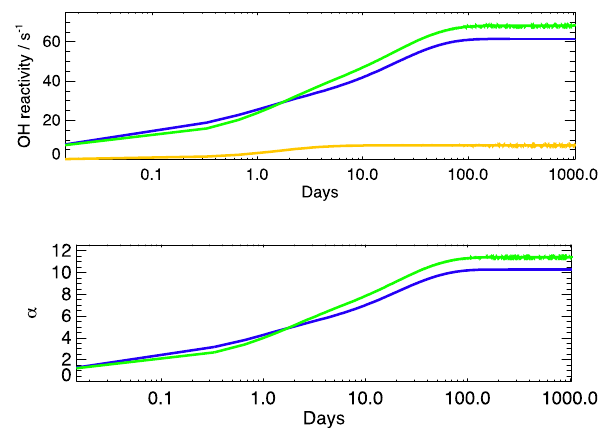
Figure 6: Time evolution of simulated OH reactivity (upper plot) and α (OH reactivity divided by the reactivity due to the primary VOC alone) (lower plot) in a model simulation with fixed Fig. 6. Time evolution of simulated OH reactivity (upper plot) and mixing ratios / concentrations of 2.5 ppbv of ethene (green), ethane (yellow), isoprene, [OH] α (OH reactivity divided by the reactivity due to the primary VOC = 2 × 10 6 molecule cm -3 (dark blue) and 2 × 10 5 molecule cm -3 (pale blue), [NO x ] = [HO 2 ] = 0, and no photolysis. alone) (lower plot) in a model simulation with fixed mixing ra- tios/concentrations of 2.5ppbv of ethene (green), ethane (yellow), In order to investigate the fate of the reactivity generated during the oxidation of isoprene, isoprene, [OH]=2 × 10 6 moleculecm − 3 (dark blue) and 2 × 10 5 and how it controls OH reactivity and the value of α , increasingly realistic conditions are now moleculecm − 3 (pale blue), (NO x )=(HO 2 )=0, and no photolysis. used in the stylised box model